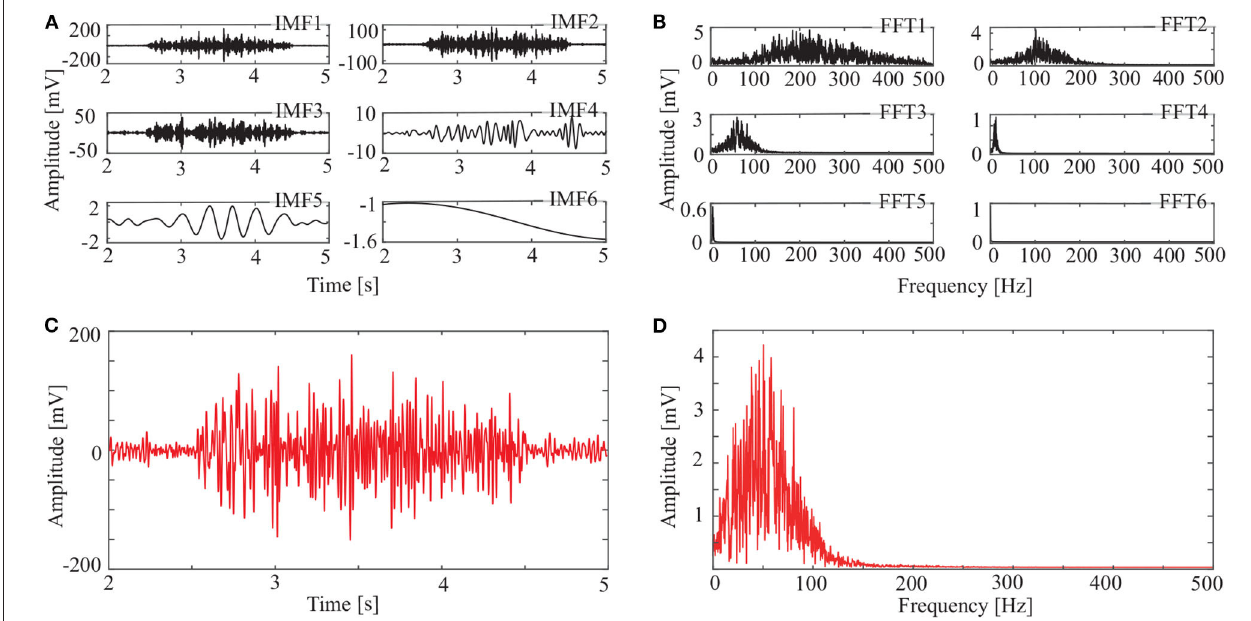
FIGURE 6 | IMFs and spectrums using OCEEMD: (A) IMFs of signal in Figure 3C , (B) corresponding FFTs, (C) reconstructed signal, and (D) spectrum of reconstructed signal.